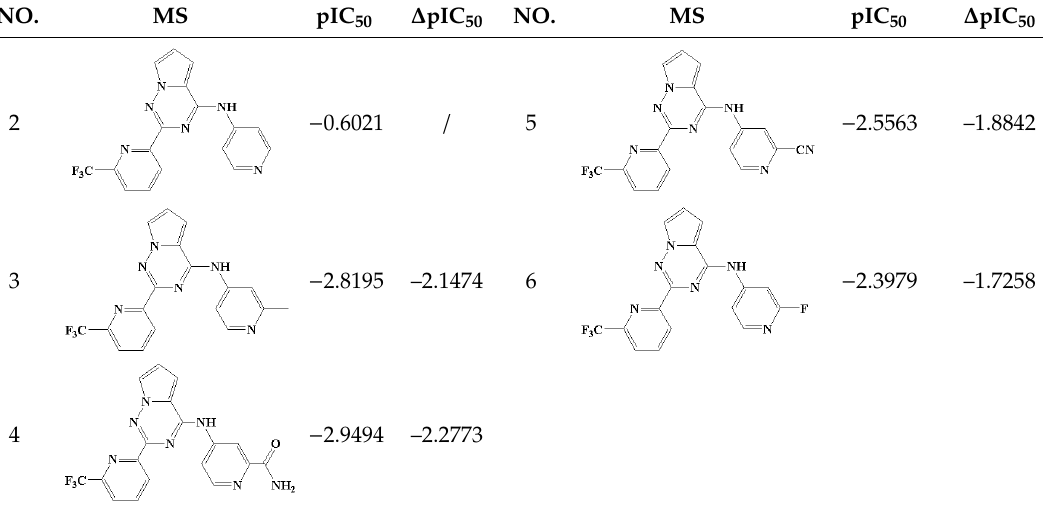
Figure 4. The binding mode of Compounds 2, 3, 4, 5, and 6 at the active site (amino acid residue SER280 in the Corey-Pauling-Koltun model, other amino acid residues in the line model and ligands in the stick model, among which Compound 2 is expressed in yellow; the receptor surface colored by the interpolated atomic charge—blue represents a positive value and red represents a negative value; the R1-position on ring A highlighted in a blue rectangle). Table 1. The structure-activity relationships in the R1-positon on Ring A.